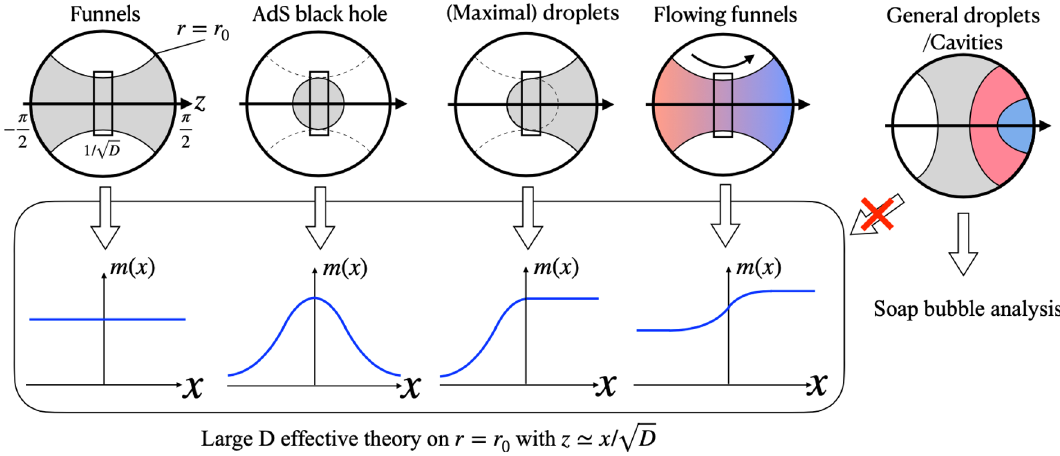
Figure 1 . Sketch of the results from the large D effective theory of AdS black strings for K = 1 . Black holes which are tangent to a r -constant surface at z = 0 can be described as the solution with different mass density profiles in the effective theory around z = 0 . For other cases, we must find the embedding shape r = r 0 ( z ) by solving the soap bubble equation